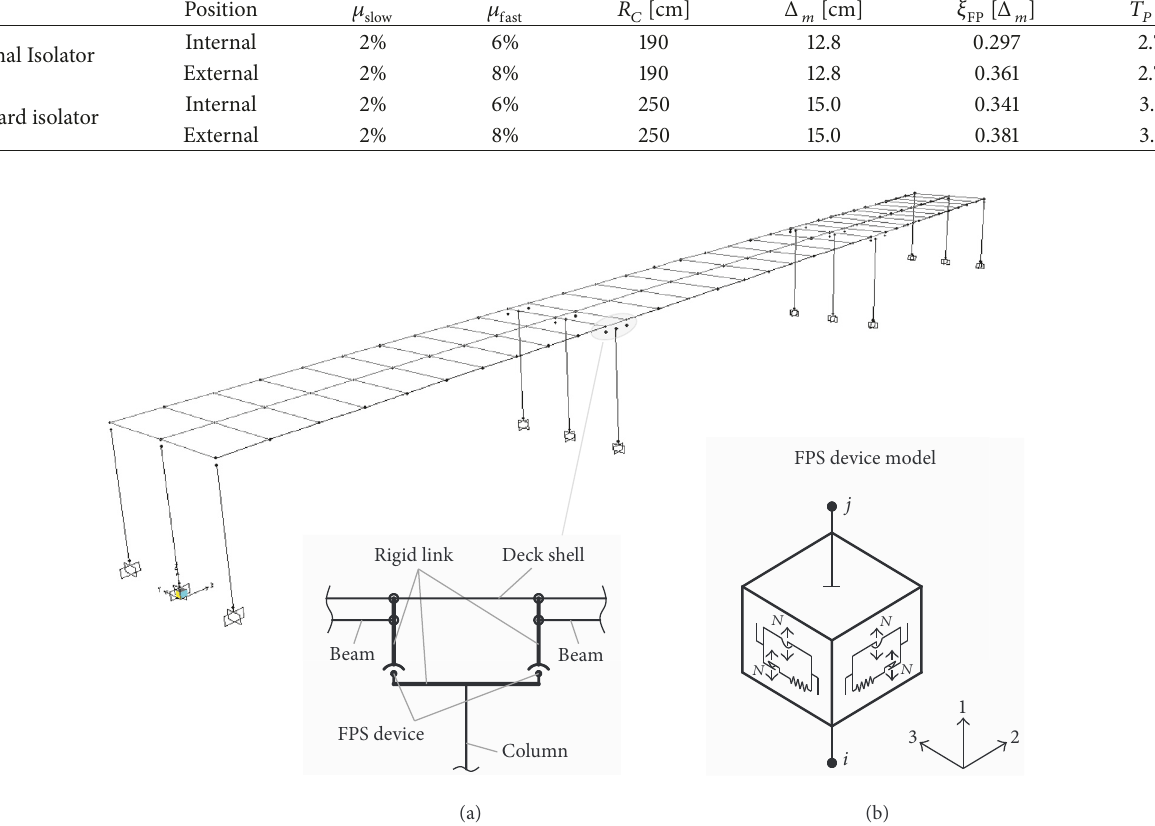
Figure 11: (a) FEM model of the seismic isolated bridge; (b) local modelling of a FPD